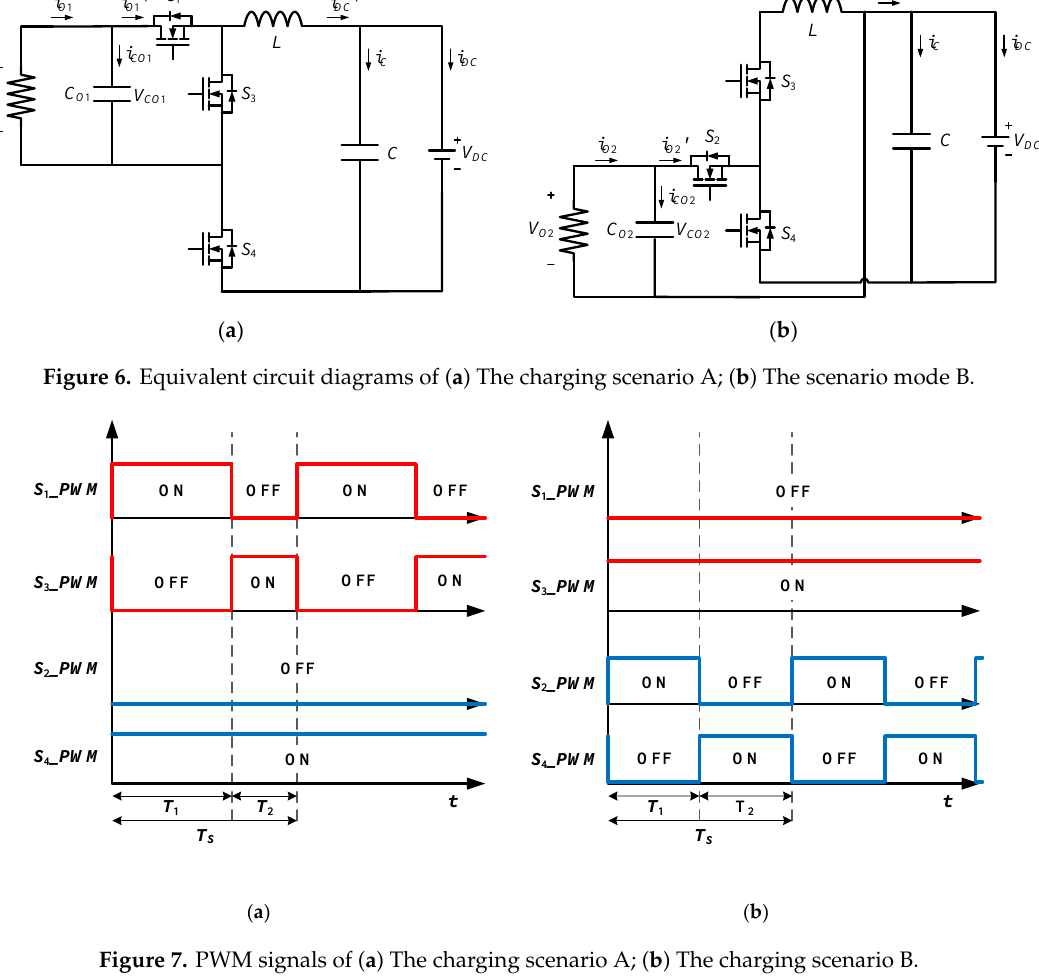
Figure 7. PWM signals of ( a ) The charging scenario A; ( b ) The charging scenario B.